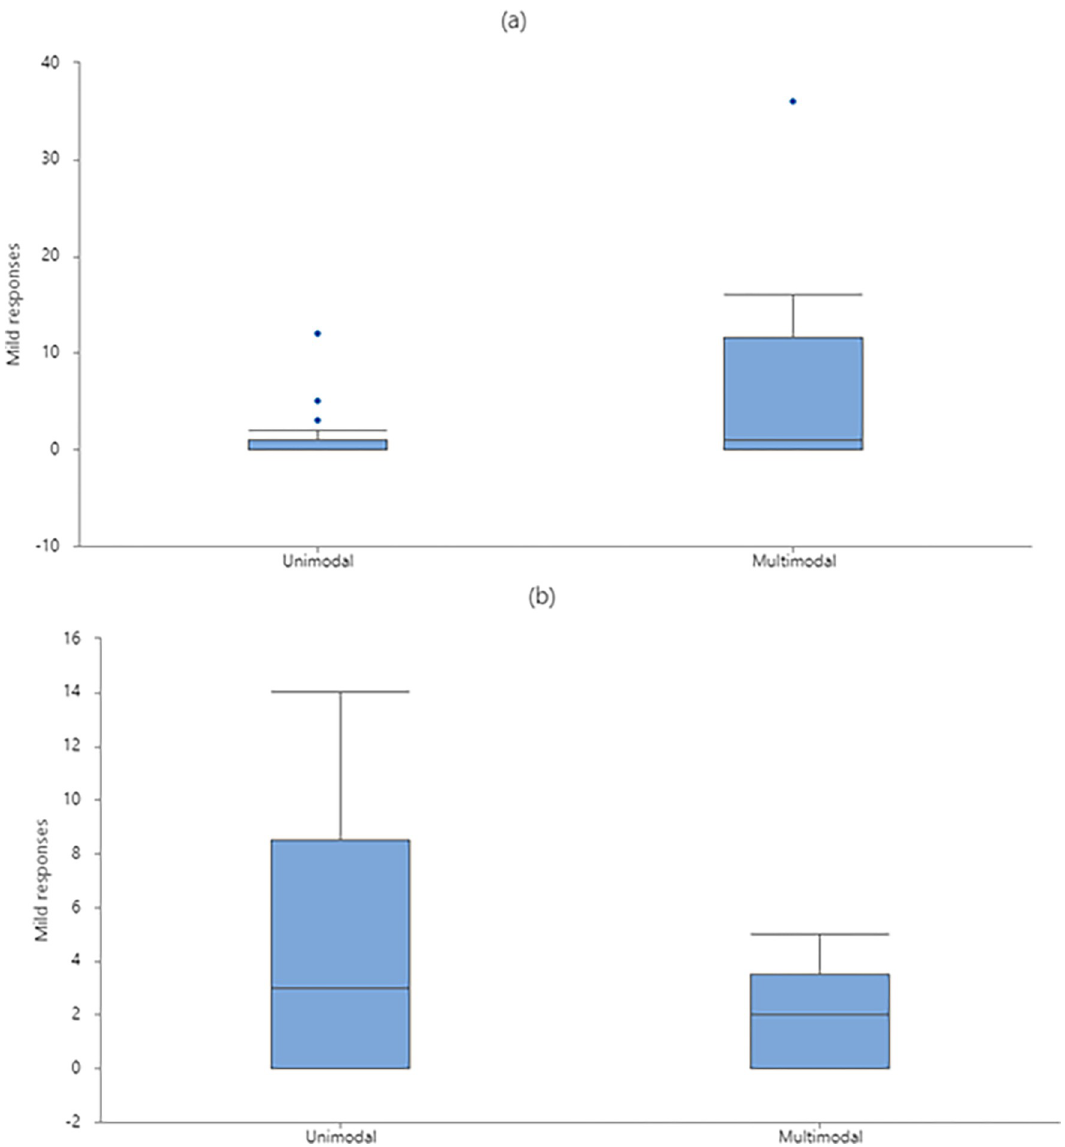
Fig 6. Occurrences of non-aggressive responses to unimodal and multimodal signals produced by white-lipped peccaries (N = 21). (a) Animals were displaying threatening behaviors. (b) Animals were displaying submissive behaviors. Box-and-whisker diagram shows the smallest and largest observations (except outlier(s); box) and lower quartile, median, upper quartile (whiskers). Points represent